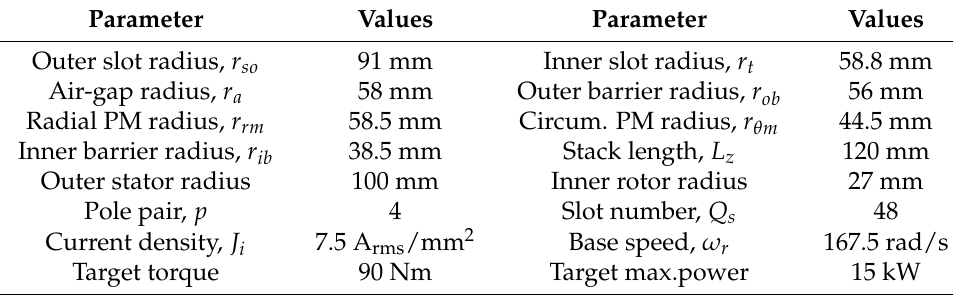
Table 1. Parameters of Delta-IPM with Uniform Slot